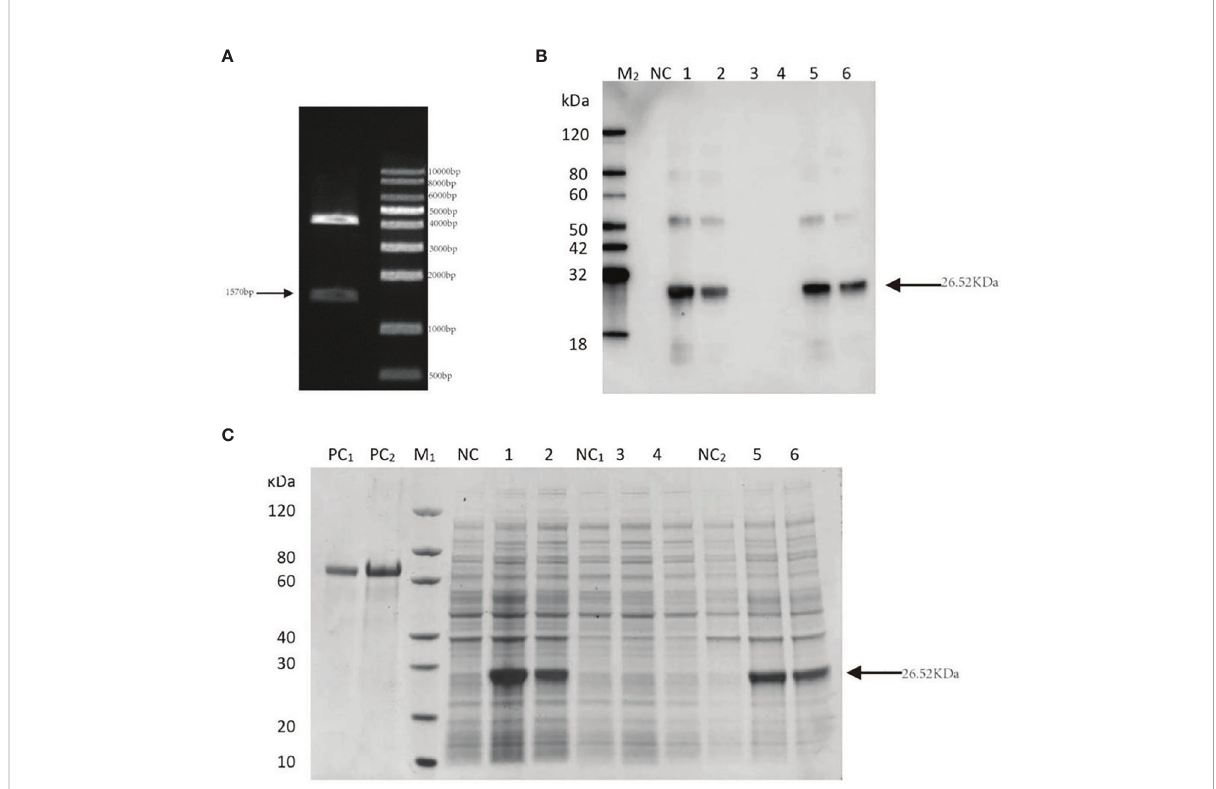
FIGURE 6 Construction of PmlysG recombinant protein. (A) Veri fi cation of recombinant plasmid of PmlysG 1: Bands of interest M: Maker. (B) SDS-PAGE (C) Western Blot. PC1: BSA (1 m g); PC2: BSA (2 m g); M1,M2: Marker; NC(whole bacteria): Cell lysate without induction; 1: Cell lysate with induction at 15°C for 16 hours; 2: Cell lysate with induction at 37°C for 4 hours; NC1(supernatant): Supernatant of cell lysate without induction; 3: Supernatant of cell lysate with induction at 15°C for 16 hours; 4: Supernatant of cell lysate with induction at 37°C for 4 hours; NC2 (precipitation): Debris of cell lysate without induction; 5: Debris of cell lysate with induction at 15°C for 16 hours; 6: Debris of cell lysate with induction at 37°C for 4